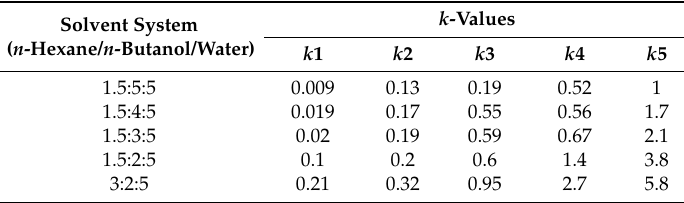
Table 1. k -values of five compounds in various solvent system.